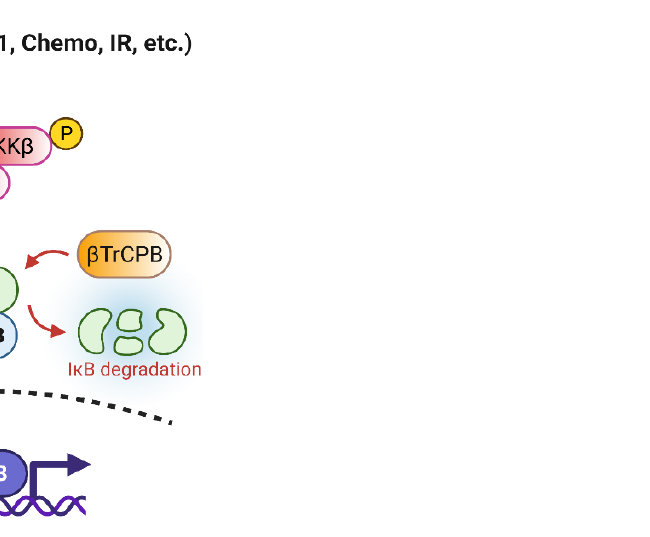
Figure 5. Overview of the NF- κ B signaling pathway. NF- κ B is inhibited by I κ B in the cytoplasm. Upon activation by upstream signals (e.g., Tumor Necrosis Factor (TNF)- α , Interleukin (IL)-1, Chemo, IR), I κ K (I κ B kinase) phosphorylates I κ B, resulting in its proteasomal degradation by the Skp_Cullin_F-box (SCF) βTRCP – ubiquitin ligase complex. Consequently, this frees NF- κ B, allowing it to be translocated into the nucleus to activate gene transcriptions that promote proliferation and